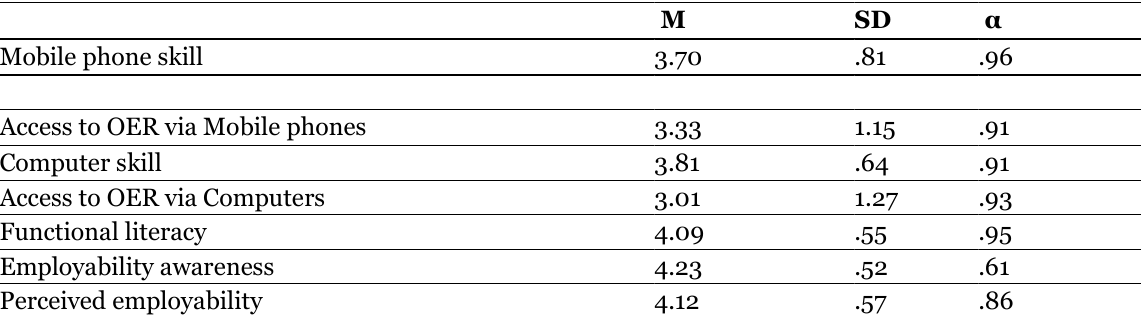
Descriptive Statistics for Key and Background